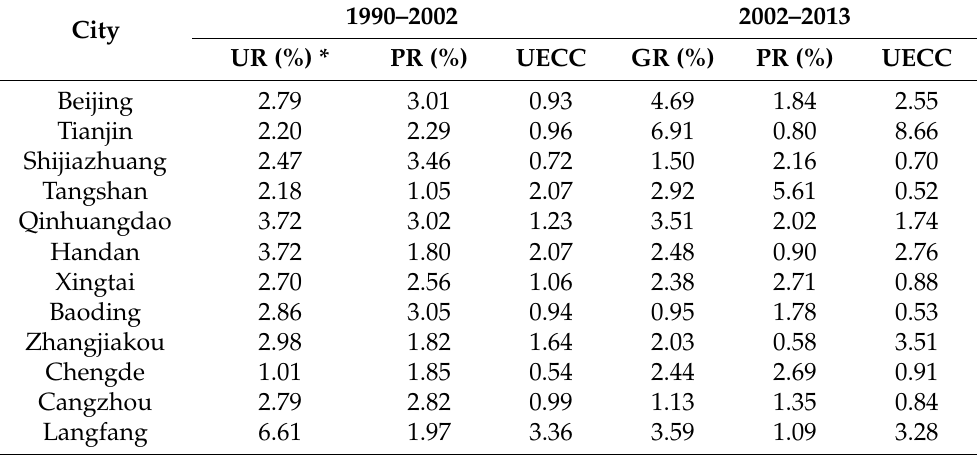
Table 2. Urban Sprawl Coordination Coefficient (UECC) from 1990 to 2013 in